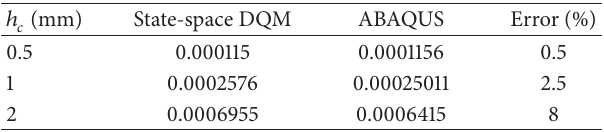
Table 5: Comparison of the frequency value associated with the second vibration mode for a clamped-clamped annular plate ( 𝑎 = 50 cm, 𝑏 = 5 cm, and 𝑚 = 1